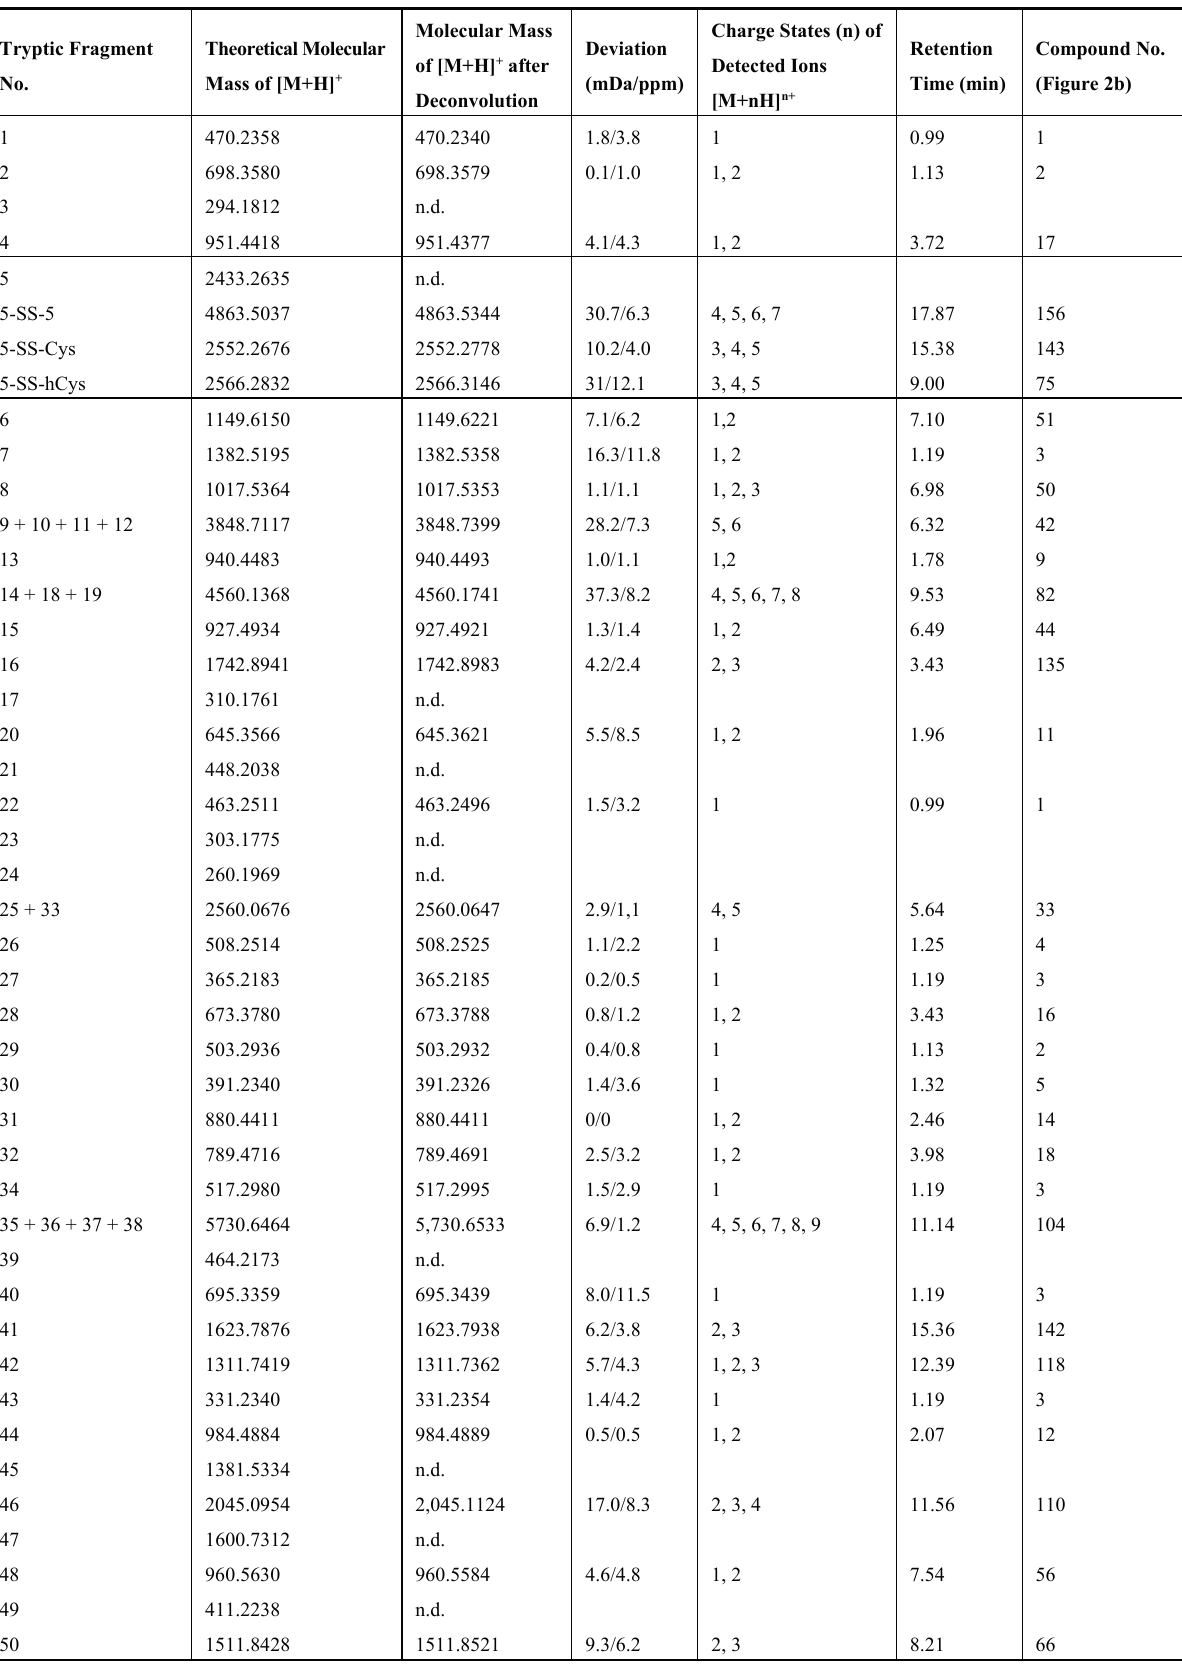
Table 1. Results of the UHPLC/+ESI-QqTOF MS analysis of the tryptic digest fragments of untreated HSA. For fragment numbering, compare Figure